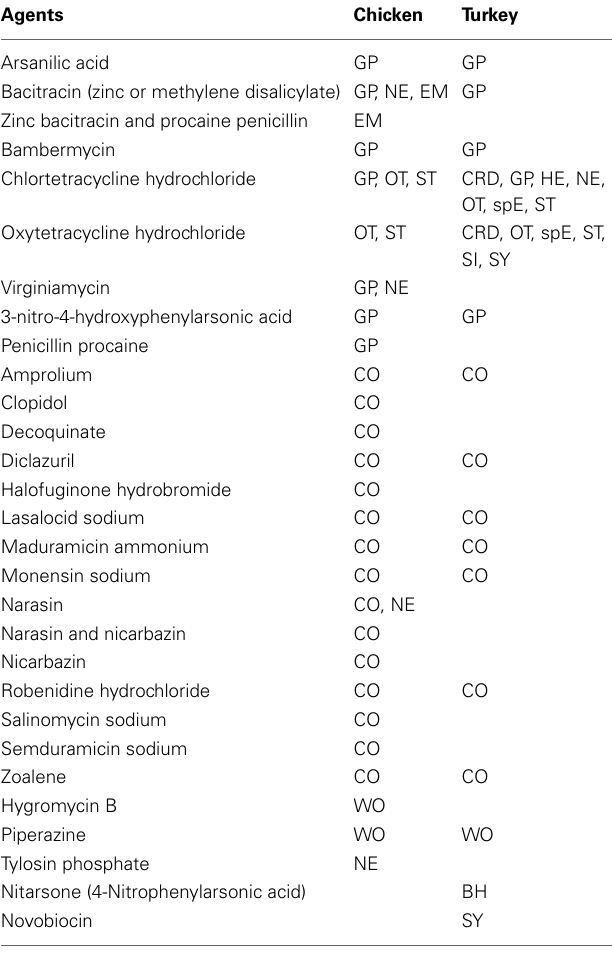
Table 1 | Agents approved as medicating ingredients in Canadian poultry